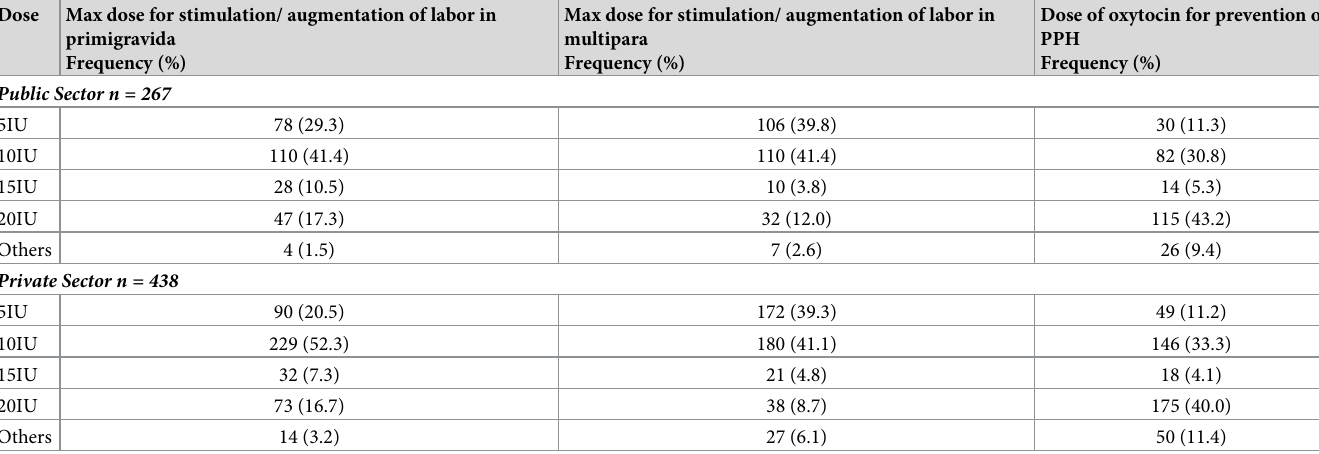
Table 7. Use and dosage of oxytocin for various obstetric indications according to respondent’s Sector of practice. Dose Max dose for stimulation/ augmentation of labor in primigravida Frequency (%)